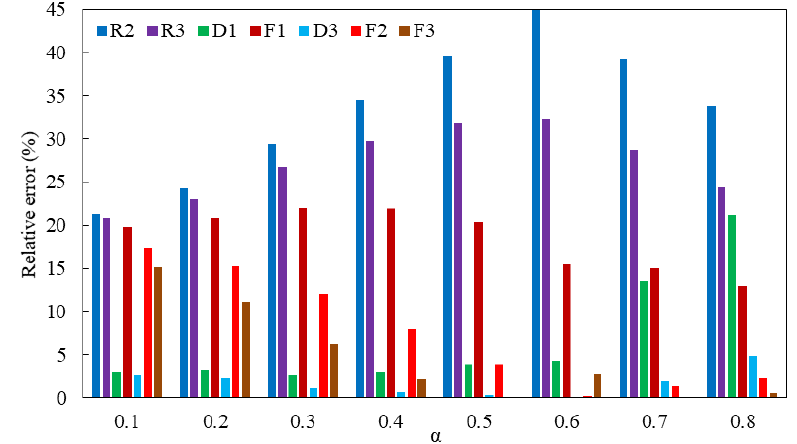
Figure 3. The relative error of the seven reaction models (F1, F2, F3, D1, D3, R2, R3).